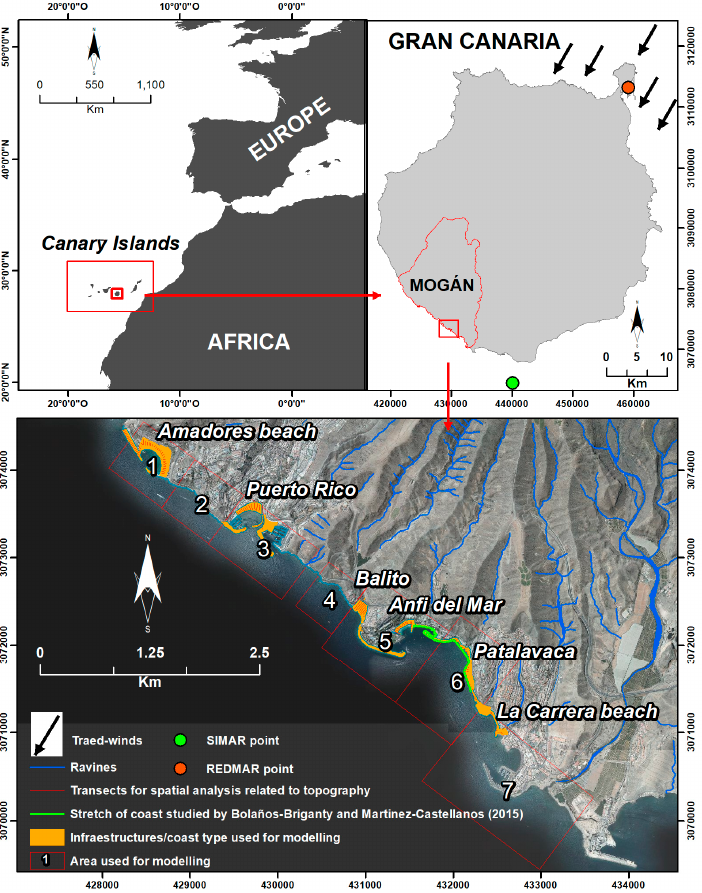
Figure 2. Study area and infrastructure/coastal type used for modelling in the present research study (see legend in the figure; left, down). (see legend in the figure; left,